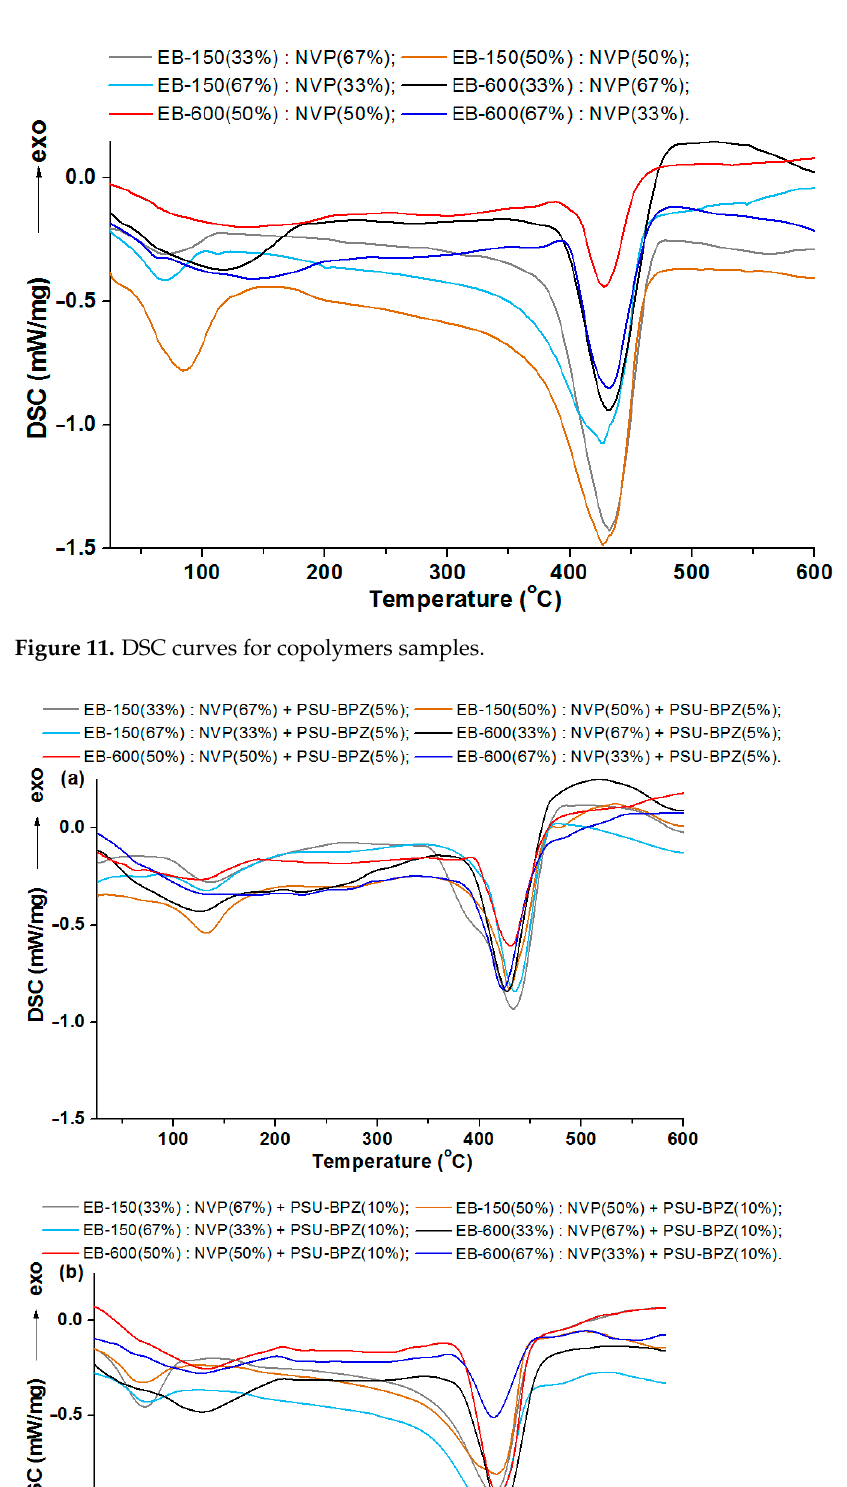
13 of 20 Figure 10. The curve of DSC analysis for bisphenol Z polysulfone. The thermogram of the PSU-BPH shows a glass transition effect which appears at about 180 °C (glass transition temperature—Tg). The Tg is followed by the undisturbed